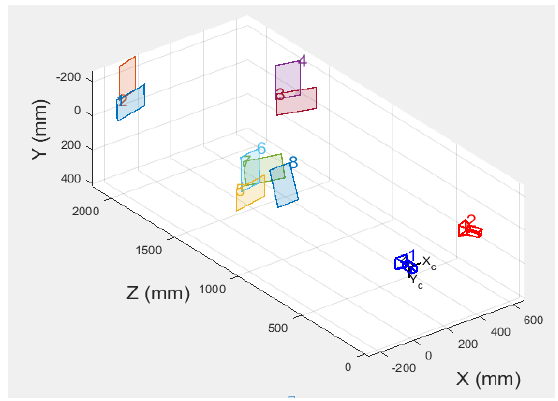
Figure 7. Extrinsic cameras visualization